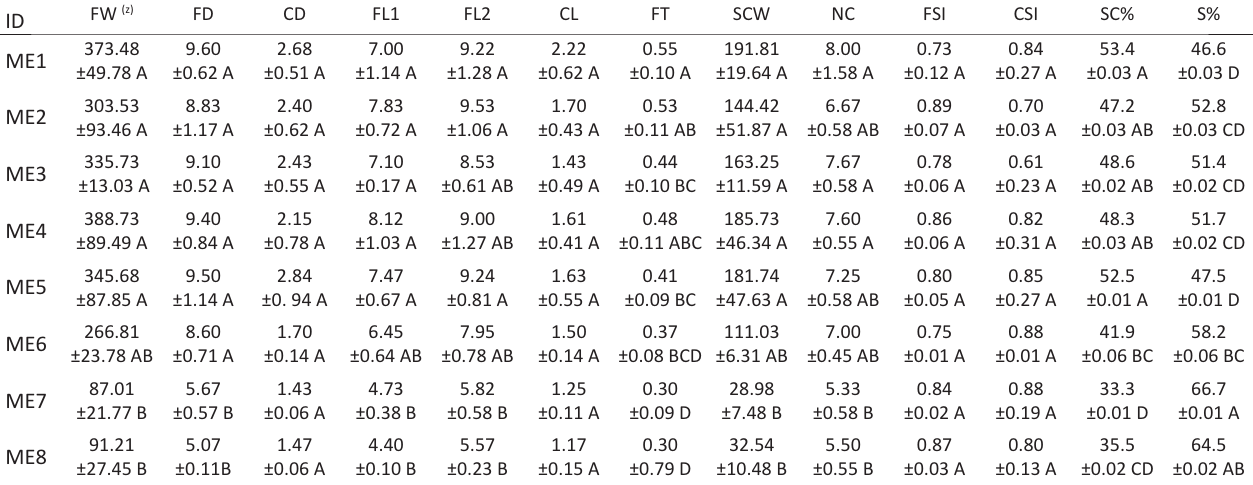
The same letter show no statistically significant differences (P<0.05). (z) For explanation of character symbols, see